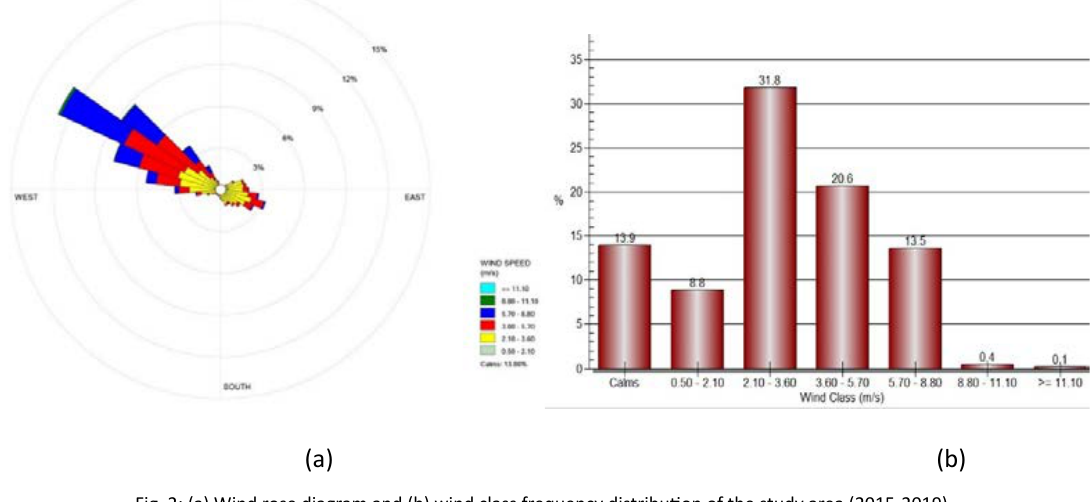
Fig. 2: (a) Wind rose diagram and (b) wind class frequency distribution of the study area (2015-2019)